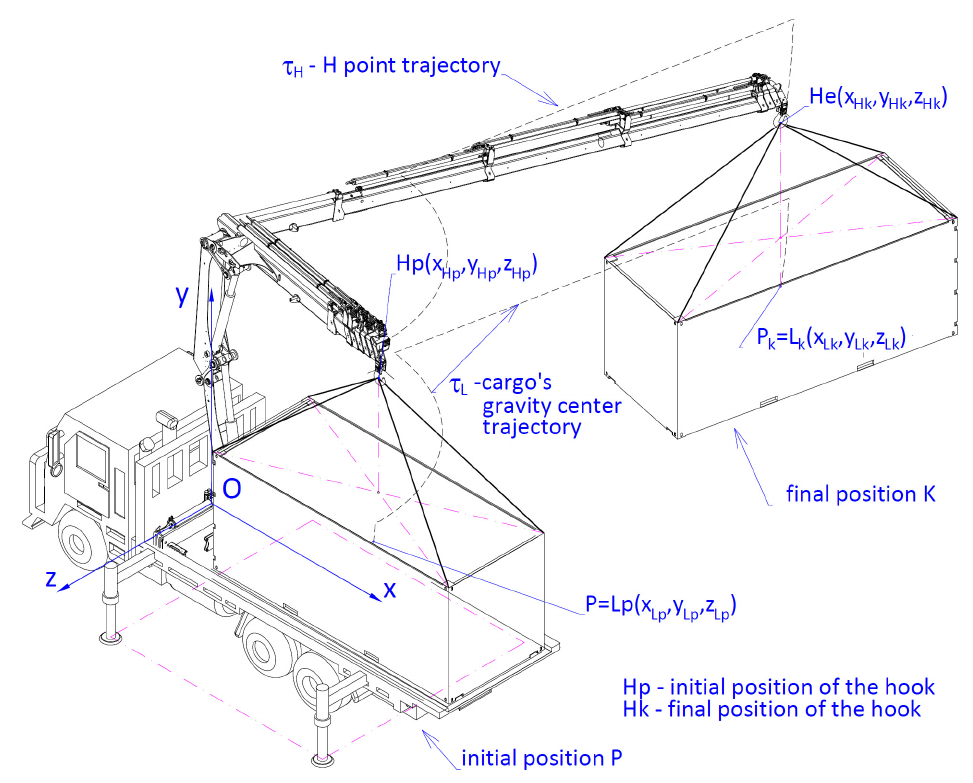
Figure 9. Working cycle of the crane’s cargo handling task. Conducting the analysis, in the case of forcing a rotary movement of the crane column with the accuracy of ± 3 σ ε 2 = ± 10 deg and retraction of the telescopic boom with the accuracy of ± 3 σ δ t 3 = ± 1 m, a significant dispersion of positioning the cargo in horizontal plane was obtained. Maximum dispersion of positioning ∆ x Pk ranged from 0 to 1.62 m (Figure 10a). In the direction towards the z axis it was ∆ z Pk = − 0.98 ÷ 1.19 m (Figure 10b). The dispersion of the crane cargo positioning was lowest in the vertical direction and it was ∆ y Pk = − 0.19 ÷ 0.19 m (Figure